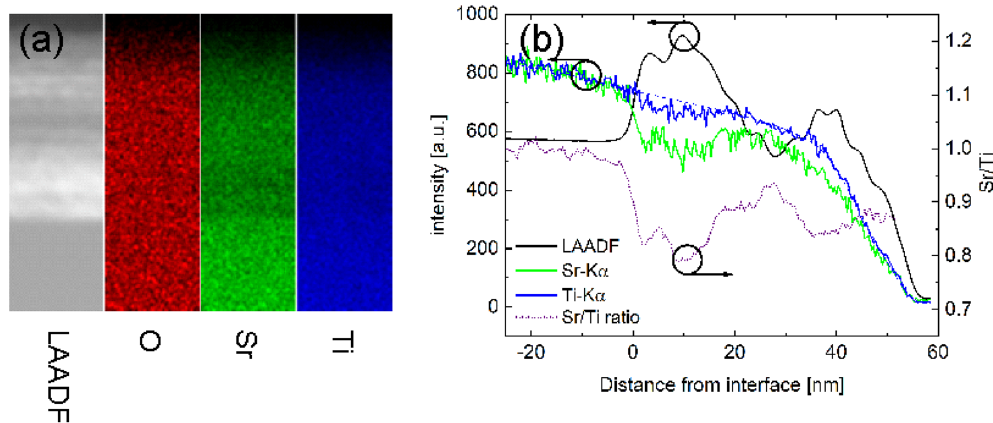
Figure 3. ( a ) STEM LAADF and the corresponding EDX maps of O, Sr and Ti of an off-stoichiometric sample with a (Sr/Ti) liq ratio of 3.2. ( b ) Quantitative analysis of the LAADF intensity (black solid curve), Sr EDX intensity (green), Ti EDX intensity (blue), as well as the ratio of the Sr/Ti EDX signal along the growth direction (purple).